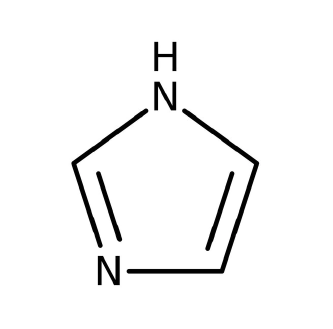
Figure 6. Chemical structure of